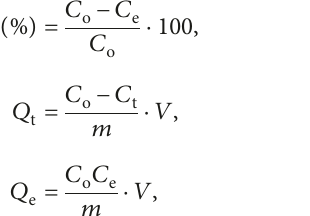
Figure 1: XRD spectra of EG, MnFe